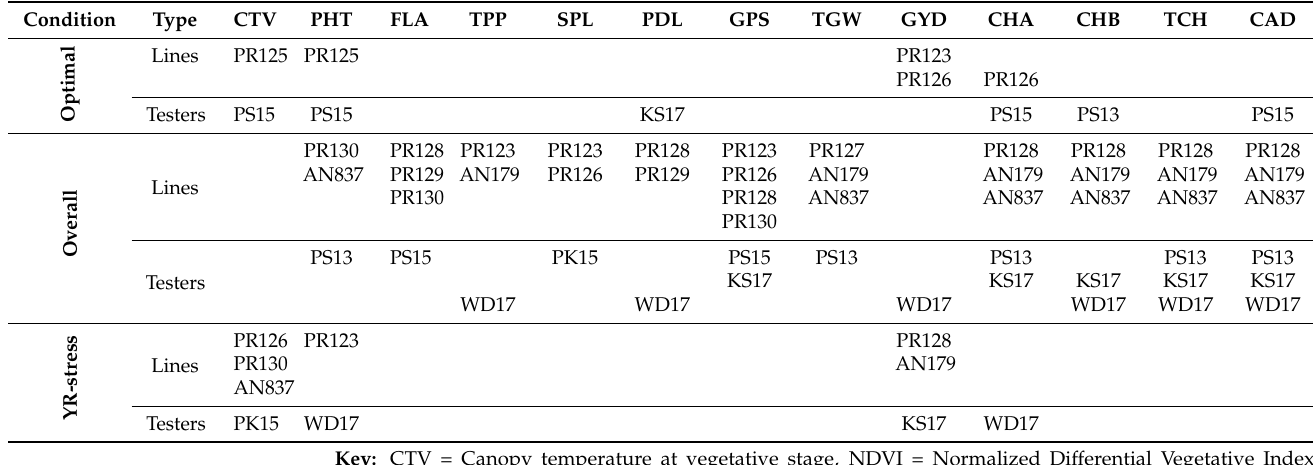
Table 4. Summary table of good general combiners for different physiological, grain yield, yield components and biochemical traits under optimal and YR-stress